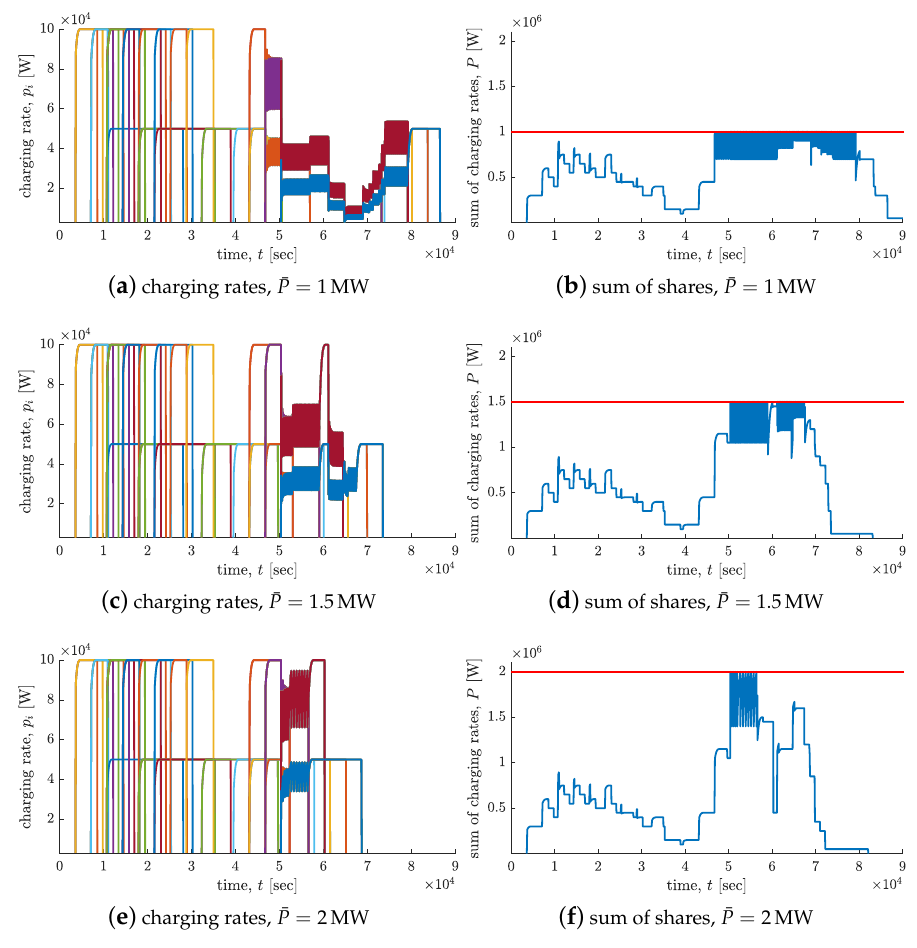
Figure 6. Simulation results in terms of charging rates and sum of shares in the case of ¯ P ∈ { 1,1.5,2 } MW and charging time slots as in Table